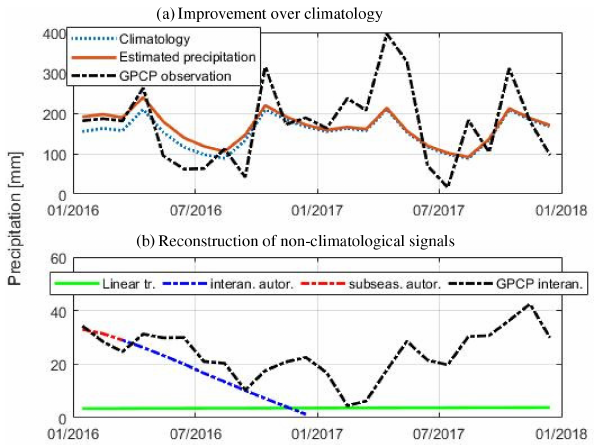
Figure 5. Reconstruction of precipitation signal for 2016–2017. (a) The reconstructed signal compared with the GPCP observations and climatology. (b) The reconstruction of a long-term secular sig- nal from the linear trend and inter-annual and sub-seasonal autore- gression compared to GPCP inter-annual signal.